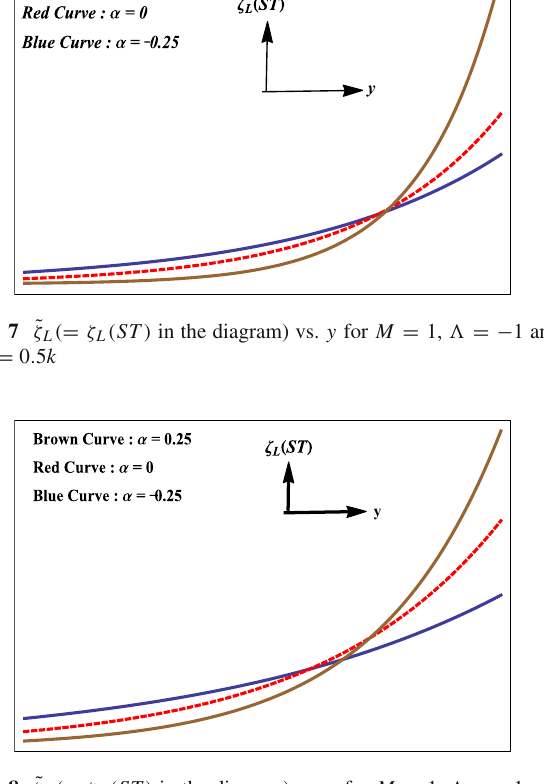
Fig. 8 ˜ ζ R ( = ζ R ( ST ) in the diagram) vs. y for M = 1, (cid:9) = − 1 and m 5 = 0 . 5